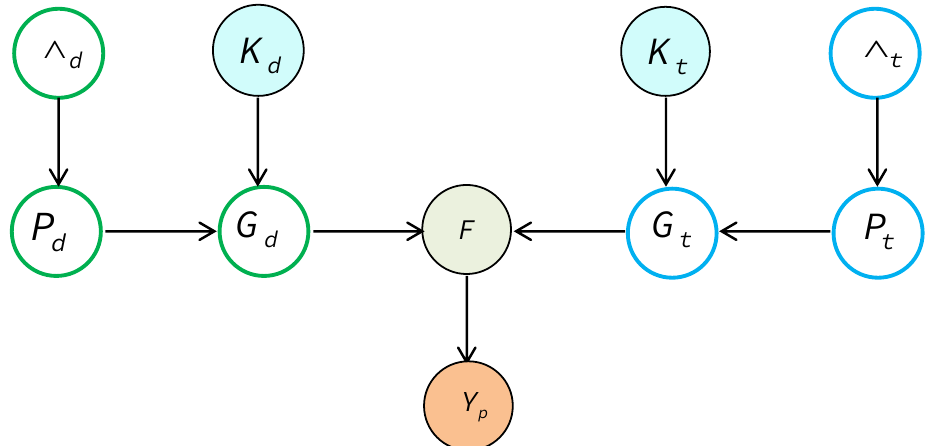
Figure 10. The flowchart of Kernelized Bayesian Matrix Factorization with twin Kernels